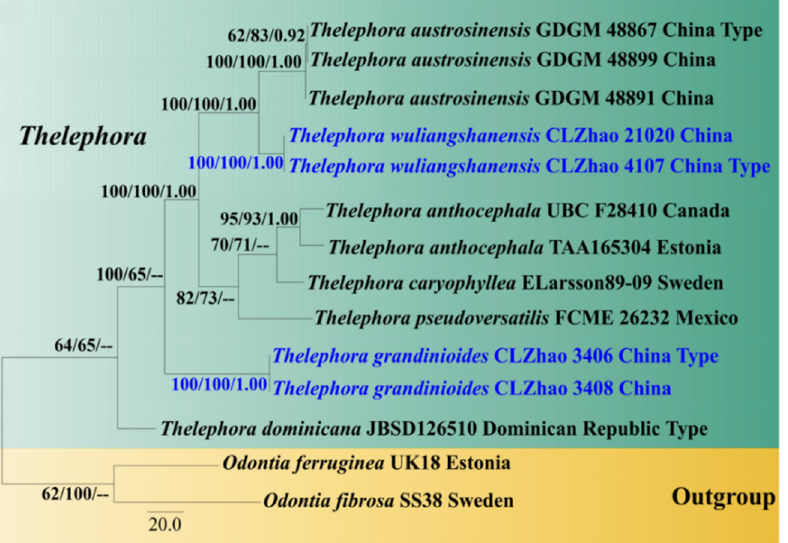
Figure 2. Maximum parsimony strict consensus tree based on the ITS+nrLSU sequences. Bootstrap support values for maximum likelihood (ML) equal to or higher than 60%, Bayesian Probability (PP) equal to or higher than 0.90, and maximum parsimony (MP) bootstrap proportions equal to or higher than 50% are mentioned above the branches (MP/ML/PP). Strains of the newly described species are depicted in blue.